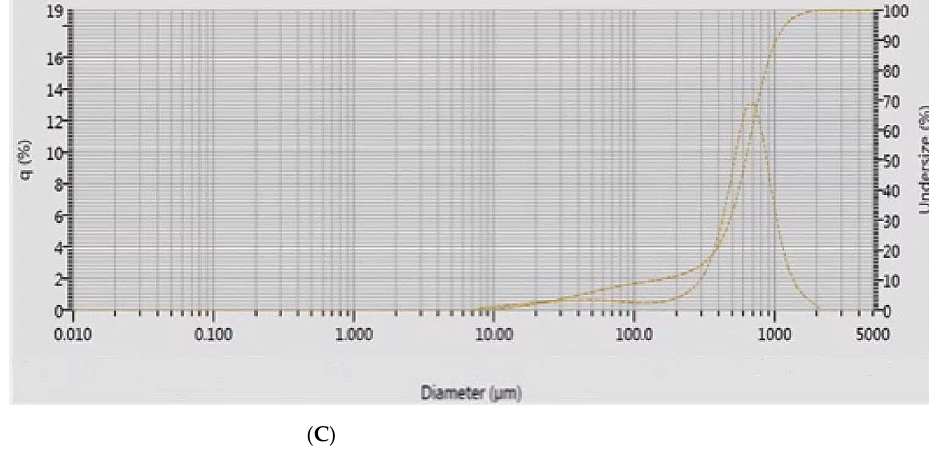
Figure 3. ( A ) Particle size distribution for spray-dried sample. ( B ) Particle size distribution for agglomeration 90 min run. ( C ) Particle size distribution for Gran 45 min run.